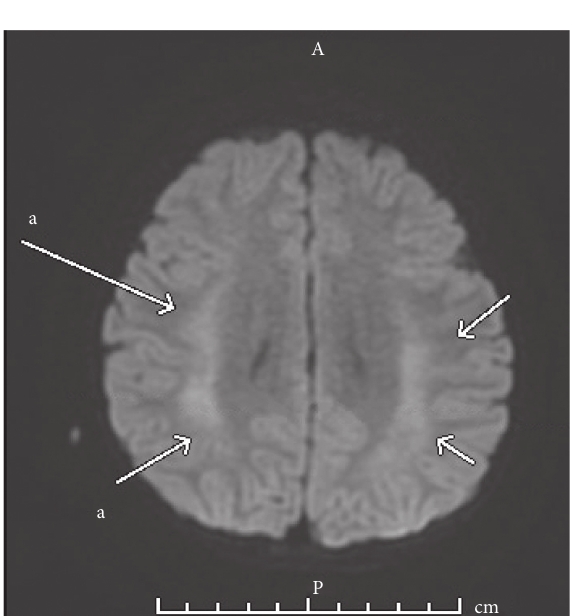
Figure 1: MRI findings on day 2 of hospitalization. Fluid-atten- uated inversion recovery axial view shows bilateral frontoparietal lobe diffusion restriction, seen in acute encephalopathy or postictal